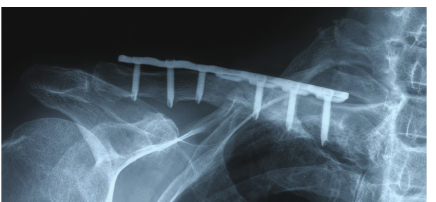
Figure 5: One-year postoperative radiograph demonstrating suc- cessful bony